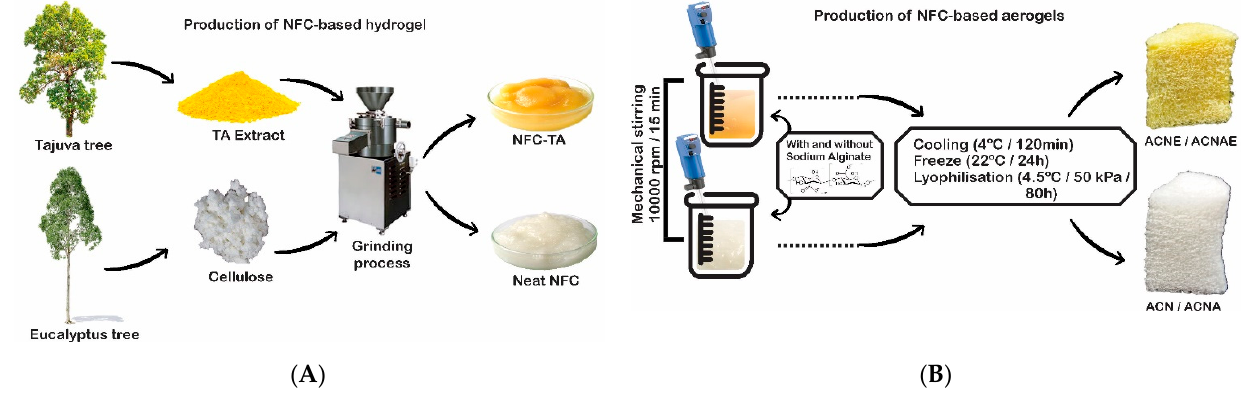
Figure 1. Production process schemes of the NFC-based hydrogels ( A ) and aerogels ( B ).